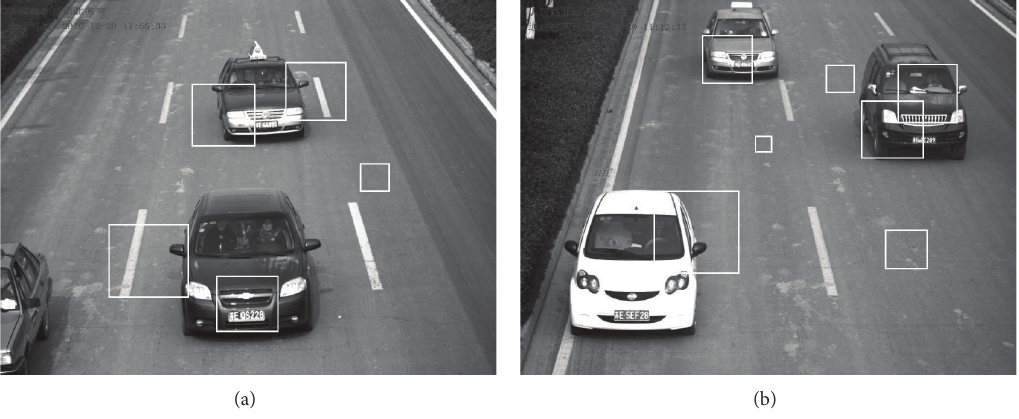
Figure 10: The detection result from Negris method in [16].